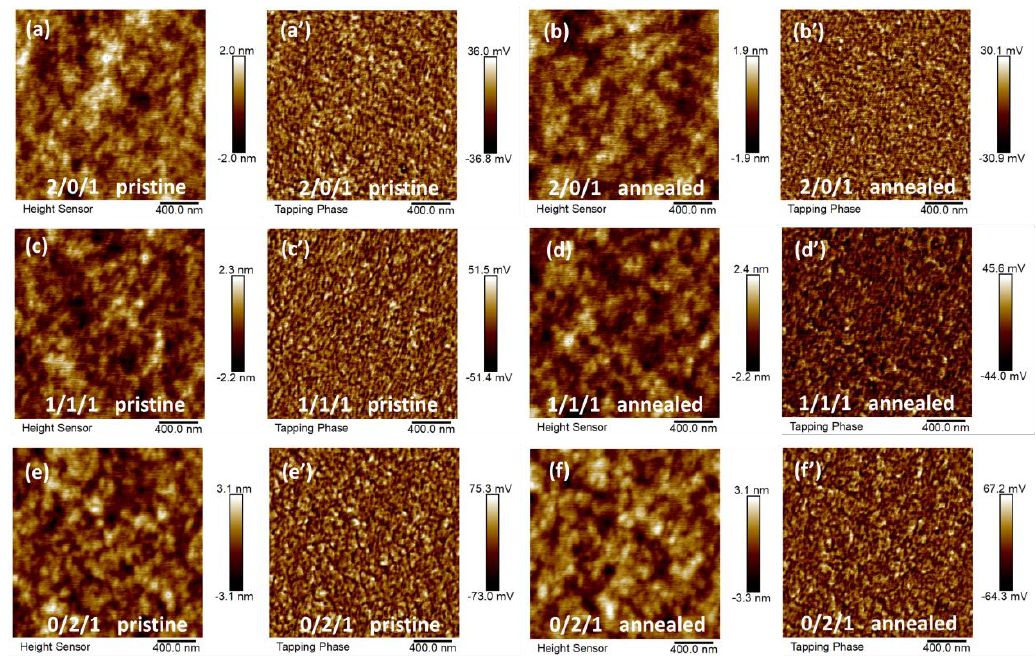
Figure 5. 2 μm × 2 μm atomic force microscopy (AFM) height ( a – f ) and phase ( a’ – f’ ) images of TQ1/PCE10/PNDI-T10 blend films without and with thermal annealing for different blend ratio: (a,b) 2/0/1, (c,d)1/1/1, and (e,f) 0/2/1.